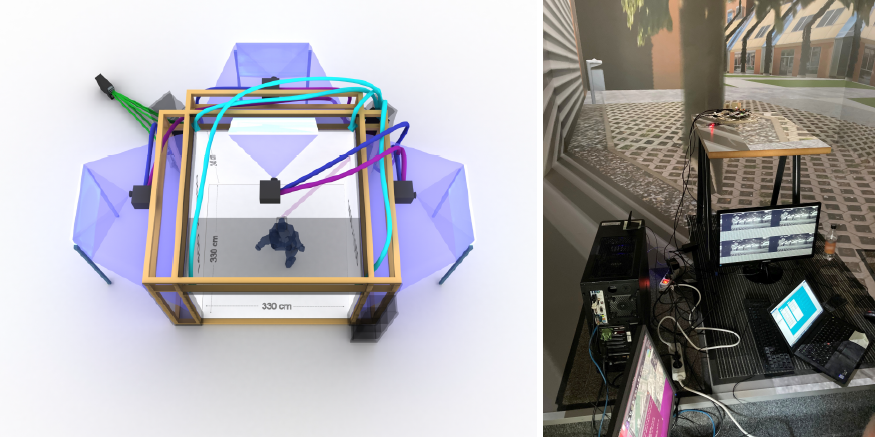
Figure 2. The Cave Automated Virtual Environment (CAVE) consists of three projected walls (left, front, right) and a projected floor. The quadratic floor has an edge length of 3.3 m and the walls are 2.5 m high ( left ). The test setup uses the CAVE, a flight simulator running on a separate computer, and the drone sensor module with two cameras placed on a table ( right